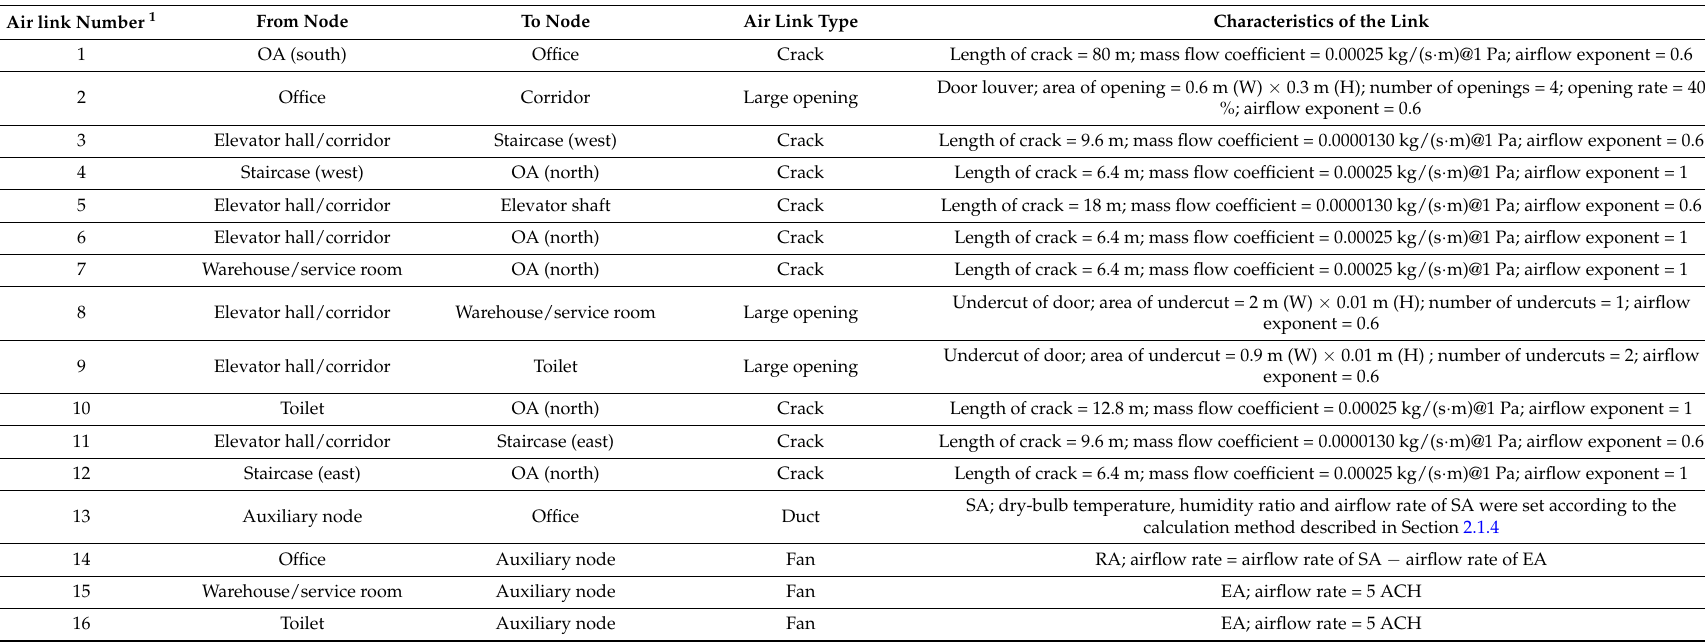
Table 7. Setup of airflow links in standard floor. OA = outdoor air; SA = supply air; RA = return air; EA = exhaust